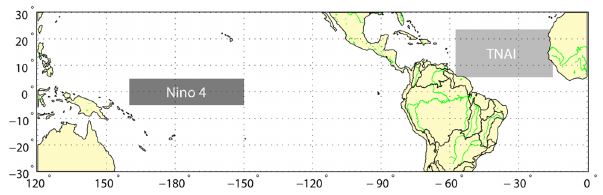
Figure 2. Central Pacific and tropical North Atlantic climate index regions (Niño 4 and TNAI; shaded gray areas). Area-weighted sea surface temperatures anomalies from these regions were found to be correlated with interannual terrestrial water storage anomalies in tropical South